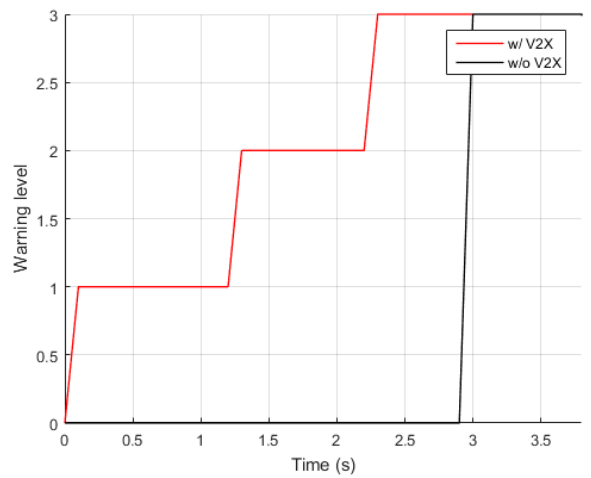
Figure 10. Collision warning generated over time in the vehicle–vehicle collision scenario. Table 9. Errors in the estimated TTC for the vehicle–vehicle collision